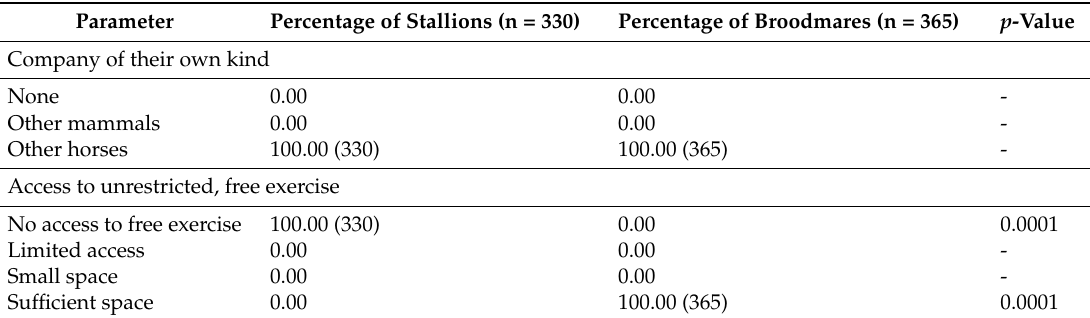
Table 5. The prevalence of parameters assessed for the investigation of freedom to express normal behaviors in each breeding horse